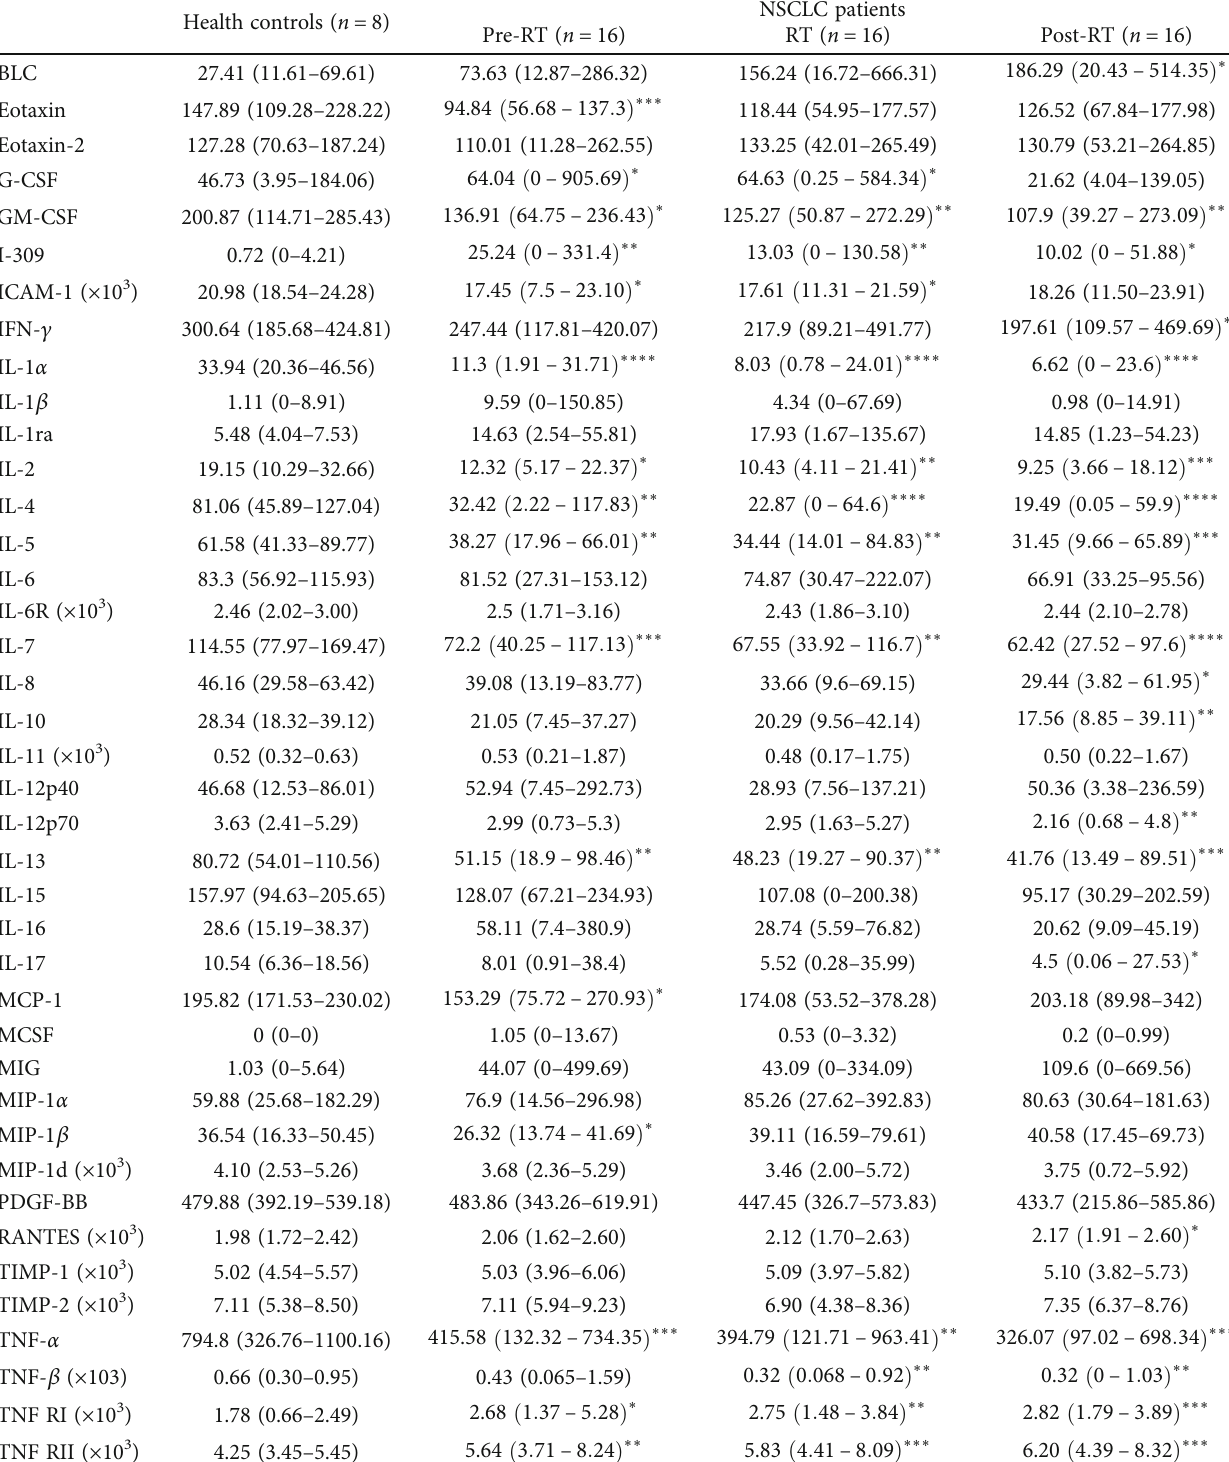
Table 5: Results of plasma cytokine assay in healthy controls and NSCLC patients